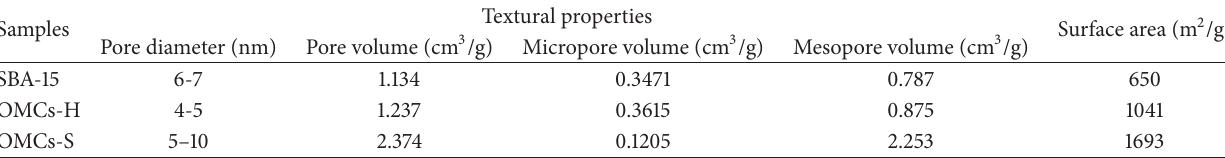
Table 1: Textural properties of